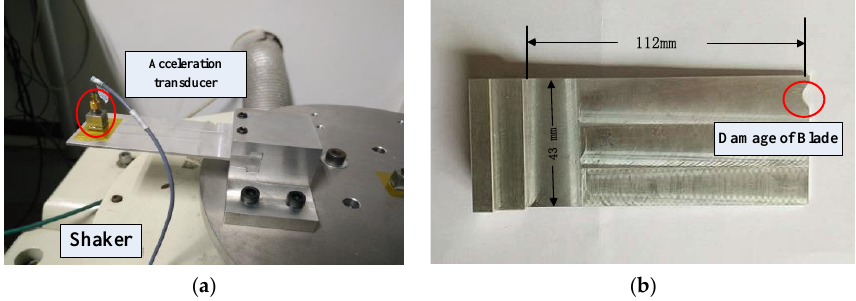
Figure 10. Vibration-based test rig ( a ) photo of testing rig ( b ) damaged testing blade of AL7075.